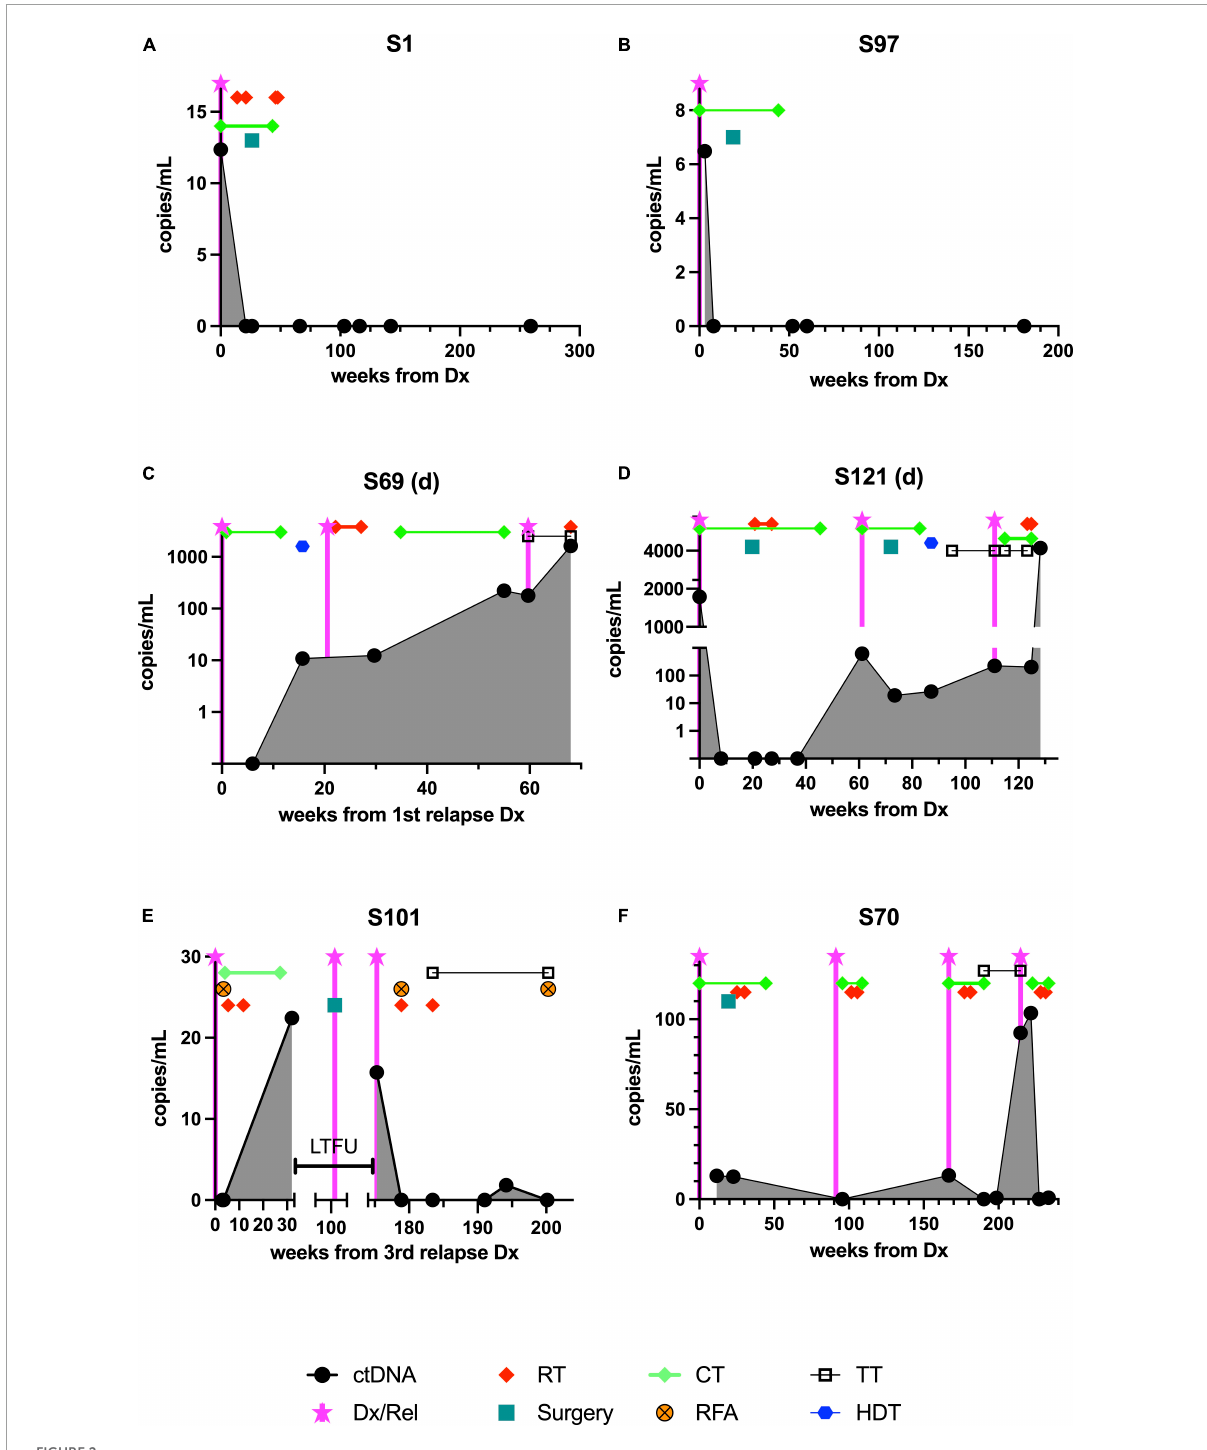
FIGURE2 The course of ctDNA detected by ddPCR in 6 patients with Ewing sarcoma during treatment and follow-up. Samples were obtained and analyzed as outlined in section “Patients and methods.” Although the time points were not standardized, the aim was to obtain a baseline sample, one taken during neoadjuvant chemotherapy, one taken during adjuvant therapy, and multiple samples taken at time points during follow-up. (A,B) The upper panel shows the time course of two patients in first complete remission (CR1), (C,D) the center panel shows results from two patients who died from relapse, and (E,F) the lower panel shows results from two patients currently receiving relapse therapy. ctDNA, cell-free tumor DNA; Dx/Rel, time point of initial or relapse/progression diagnosis; RT, radiotherapy; CT, chemotherapy; RFA, radiofrequency ablation; TT, targeted therapy; HDT, high-dose chemotherapy followed by autologous stem cell rescue; LTFU, time period when patient was lost to